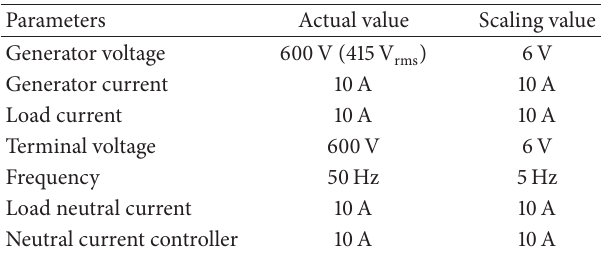
Table 1: Scaling